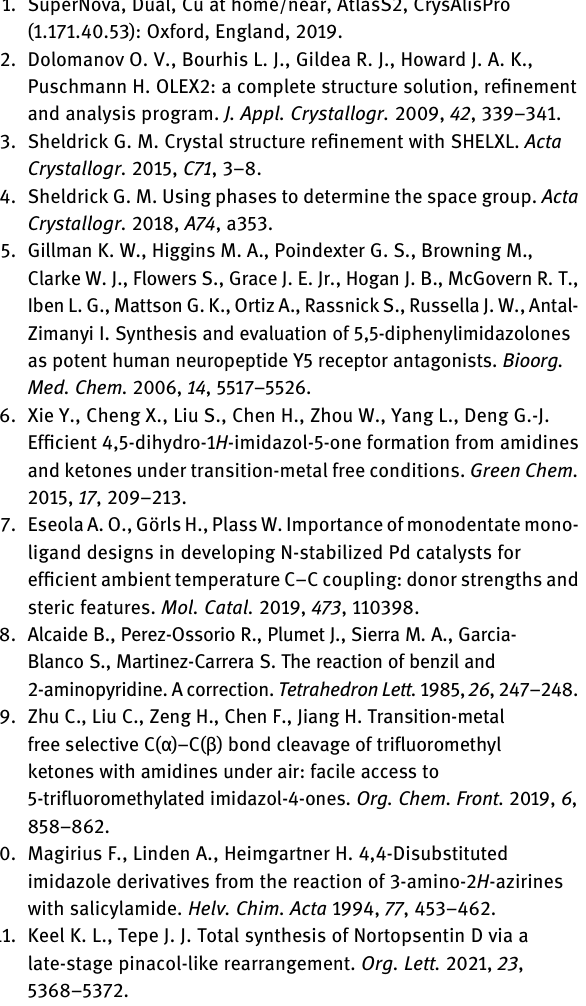
/ c 1 H N O. The title molecule 21 16 2